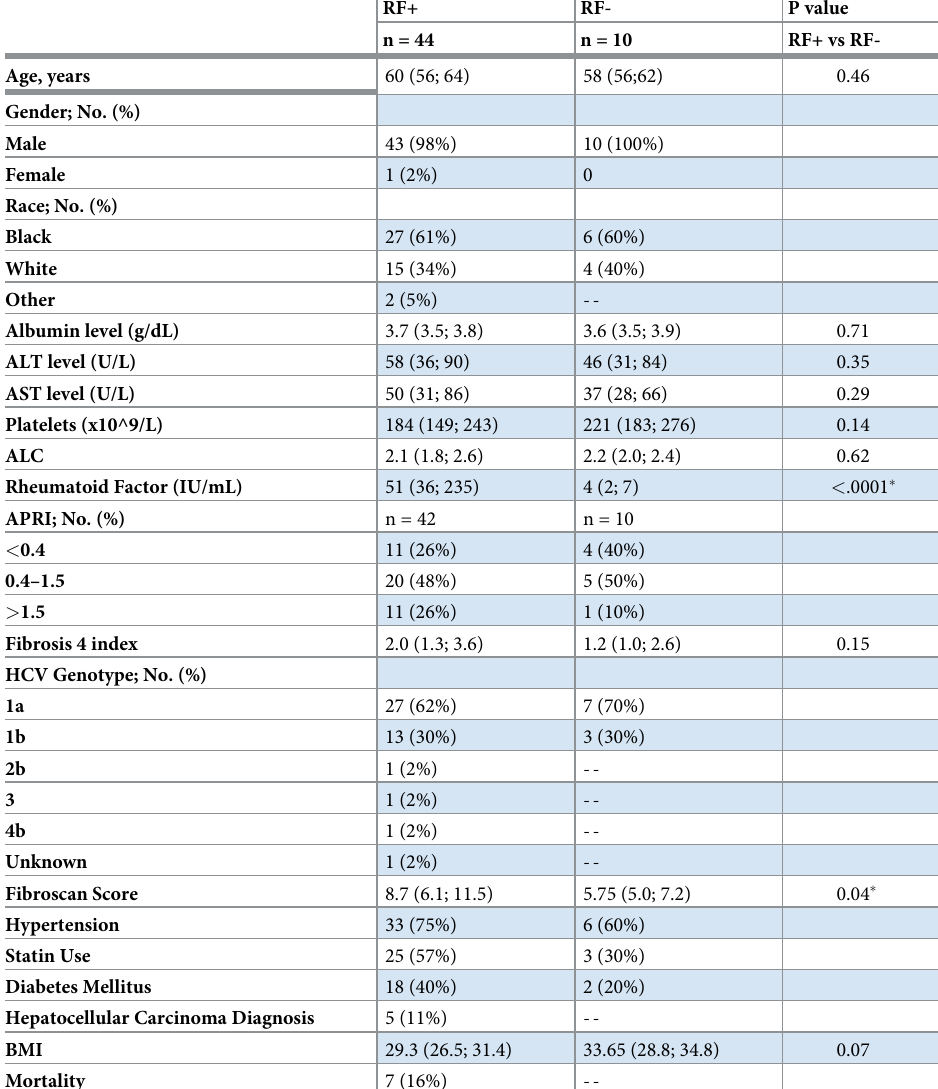
Table 1. Clinical characteristics of HCV infected RF+ and RF- participants at baseline (before the initiation of DAA